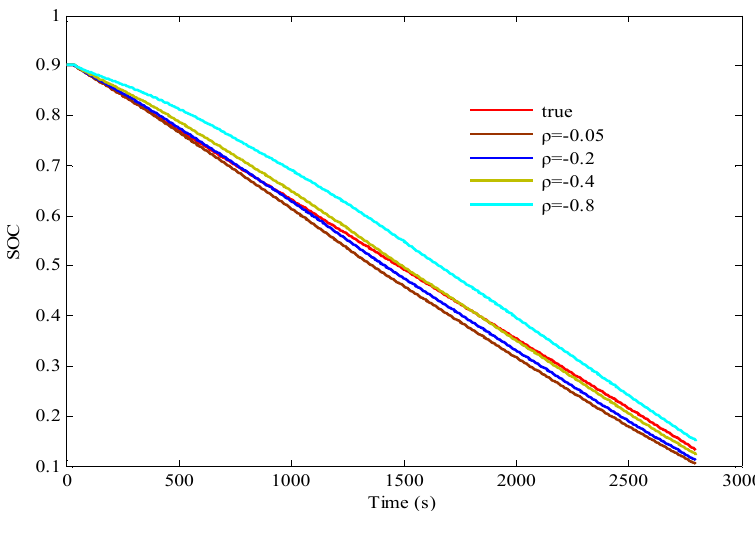
Figure 6. Modified result of Robust EKF estimation with different bias value at the discharge current of 1C (SOC = 0